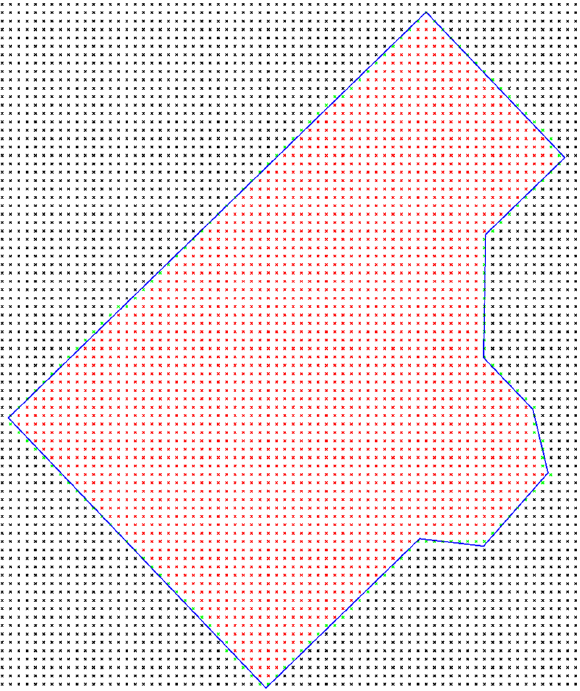
Figure 9. Discretization of the plane of the house. Black points are outside the house, green points give the contour of the house, red points are inside. Algorithm 4 Optimum Excavation/Filling (AOEF):